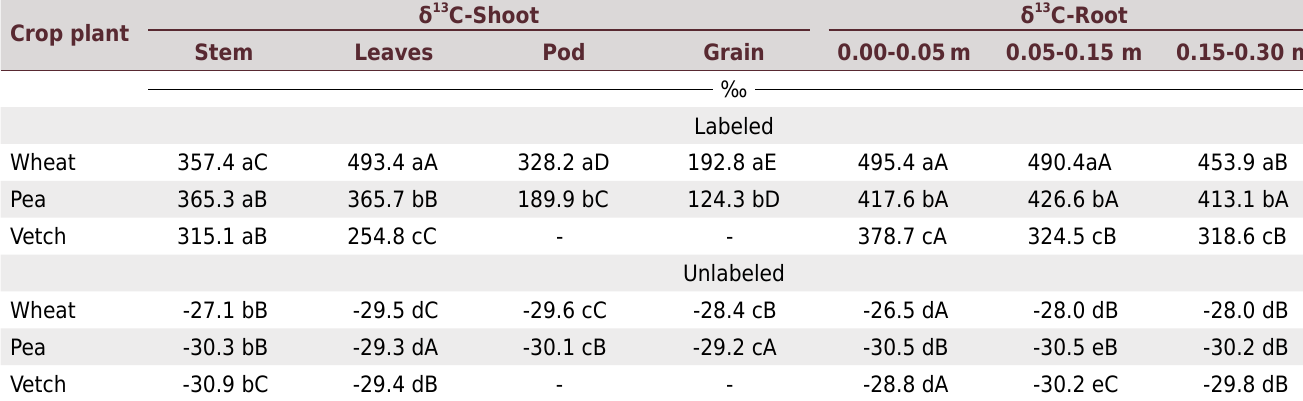
Table 3. δ 13 C values of labeled and unlabeled parts of crop plants grown under field conditions Crop